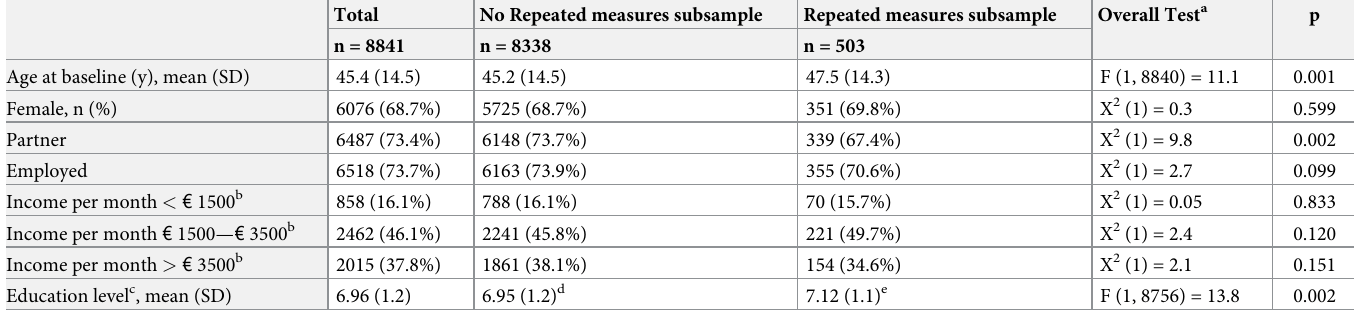
Table 2. Seasonal distribution of demographic variables in the subsample of respondents with repeated measures.